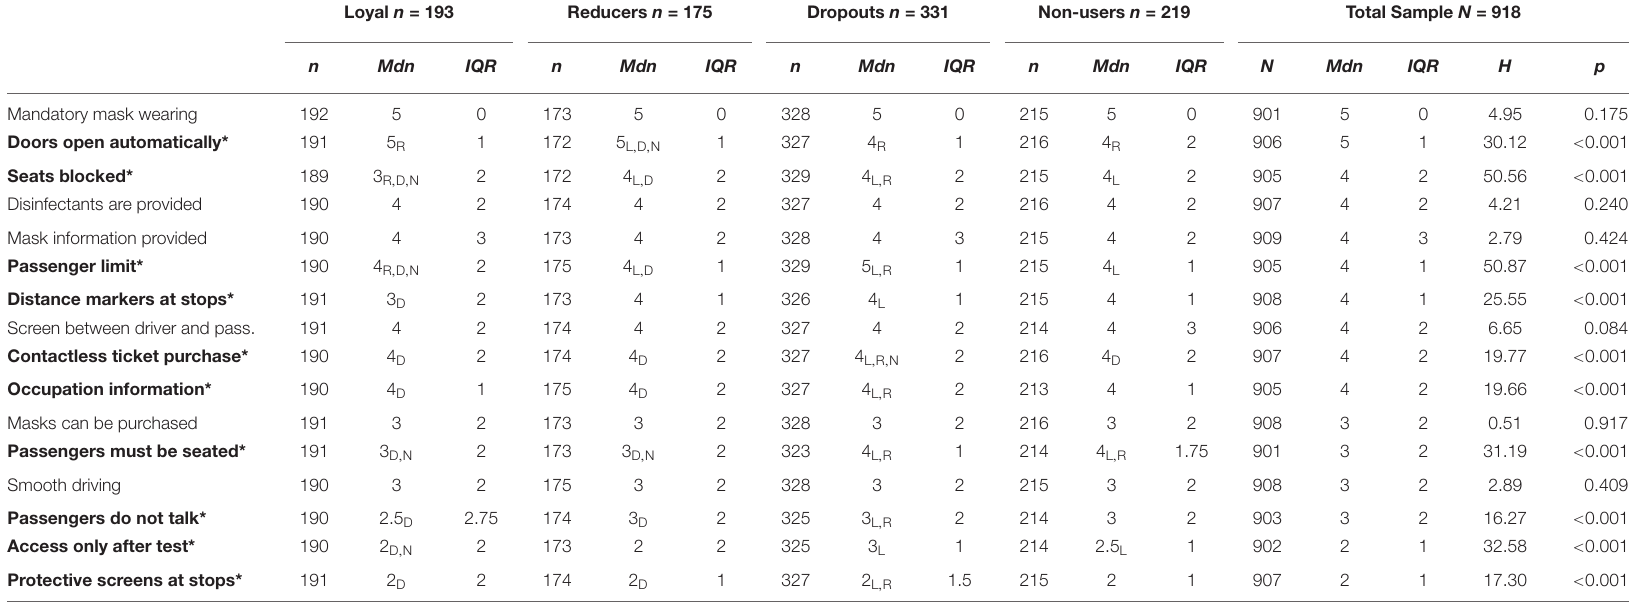
TABLE 5 | Evaluation of the different measures taken against COVID-19 in public transport by the four target